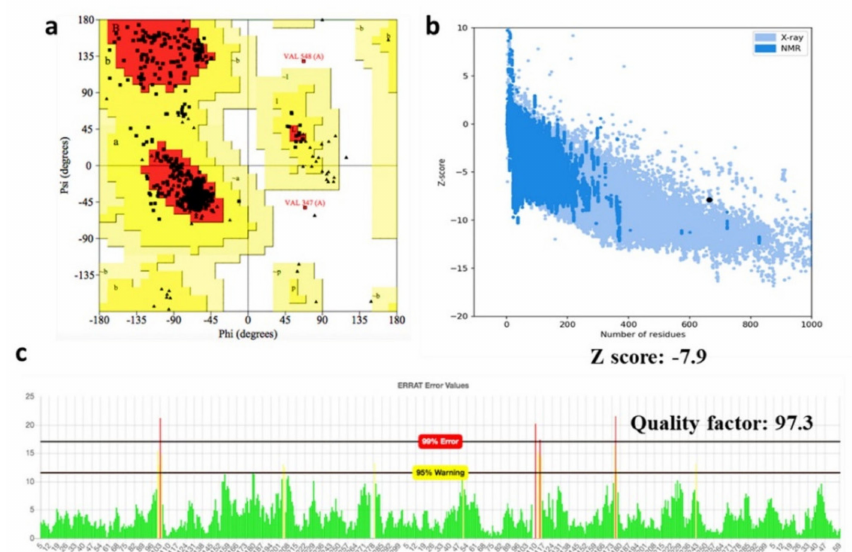
Figure 4. Vaccine 3D structure modeling and validation. ( a ) Ramachandran plot of the predicted 3D structure ( b ) PROSA Z-score of the vaccine, ( c ) ERRAT validation for the predicted